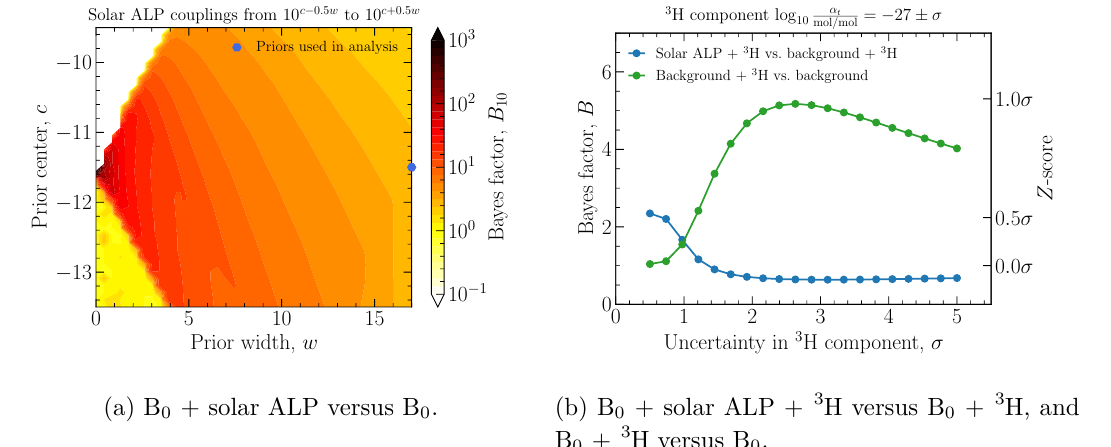
Figure 7. Dependence of the Bayes factor with only Xe data on (a) the prior for the solar ALP couplings and (b) the width of the prior for the 3 H component of the background. The alternative y -axis on the right-hand side of (b) shows the Bayes factor converted into a Z -score by eq.